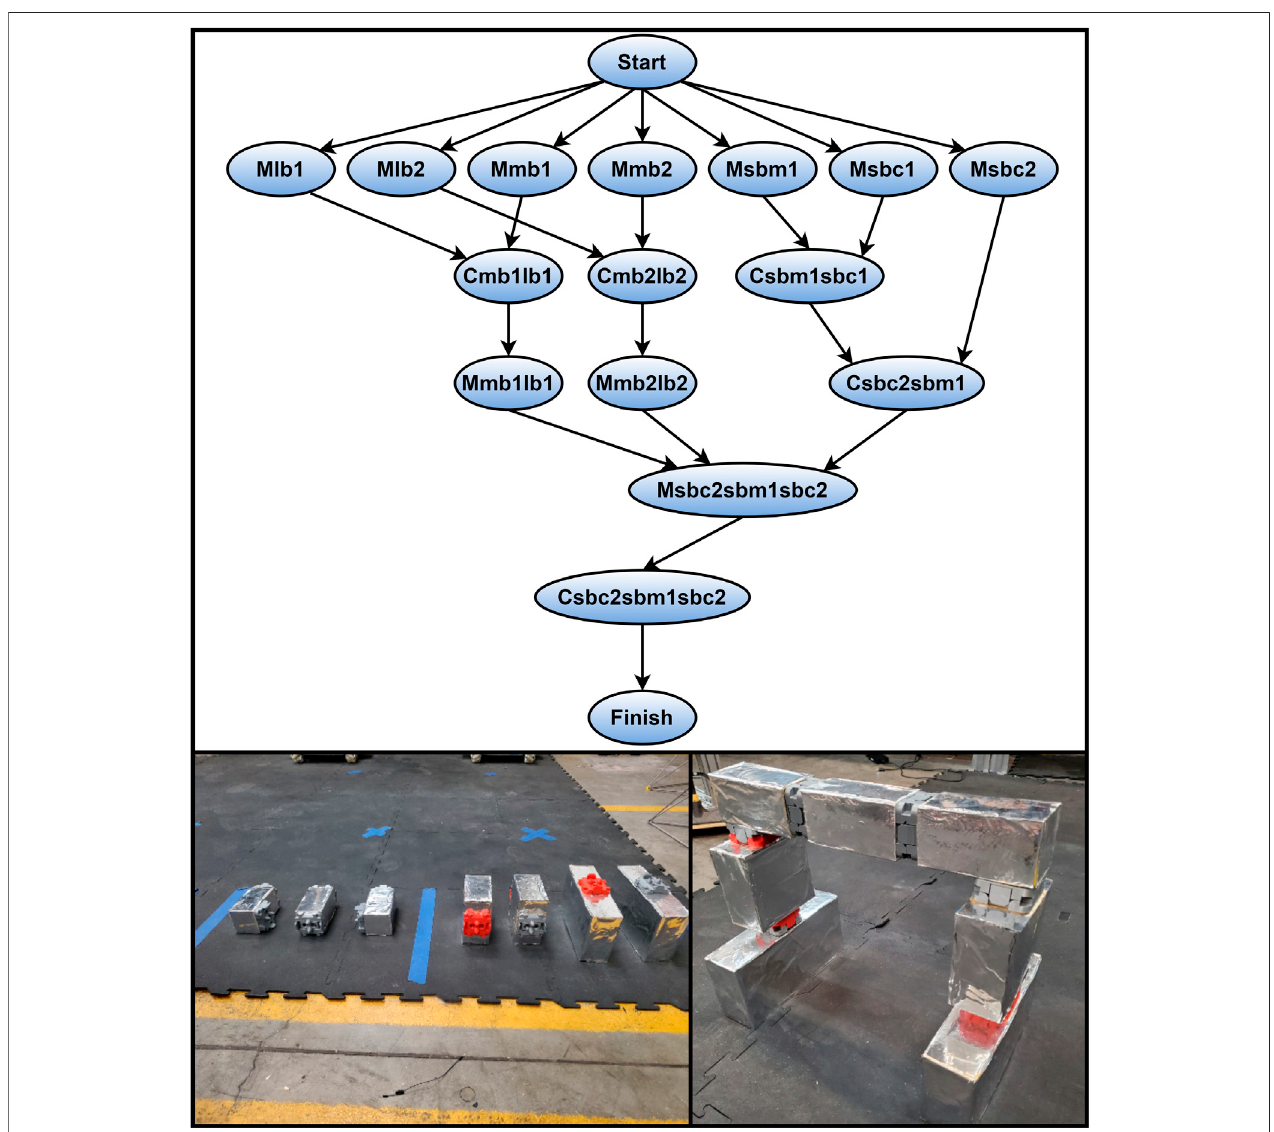
FIGURE 3 | Precedence DAG for arch assembly project, Initial assembly state, Final assembly state.